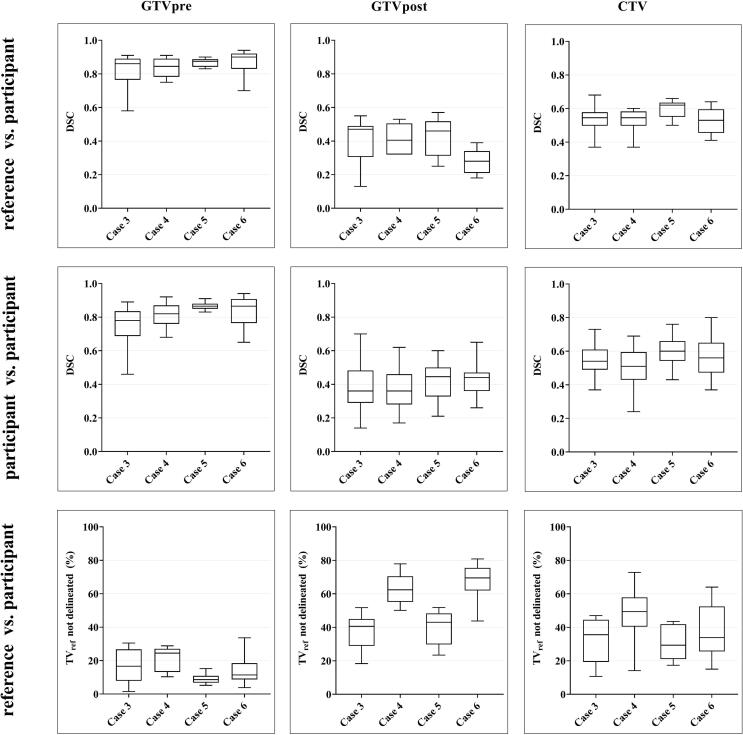
Boxplots for DSCref/obs, DSCobs/obs and TVref not delineated for case 3–6 per target volume. For a total of 38 delineation sets (2 missing) that were completed by the participants, the boxplots depict the DSCref/part (upper row), DSCpart/part (middle row) and TVref not delineated (lower row) of case 3–6 per target volume. Abbreviations: TVref, reference target volume; DSC, Dice Similarity Coefficient; GTVpre/post, pre- and postoperative Gross Tumor Volume, respectively; CTV, Clinical Target Volume.